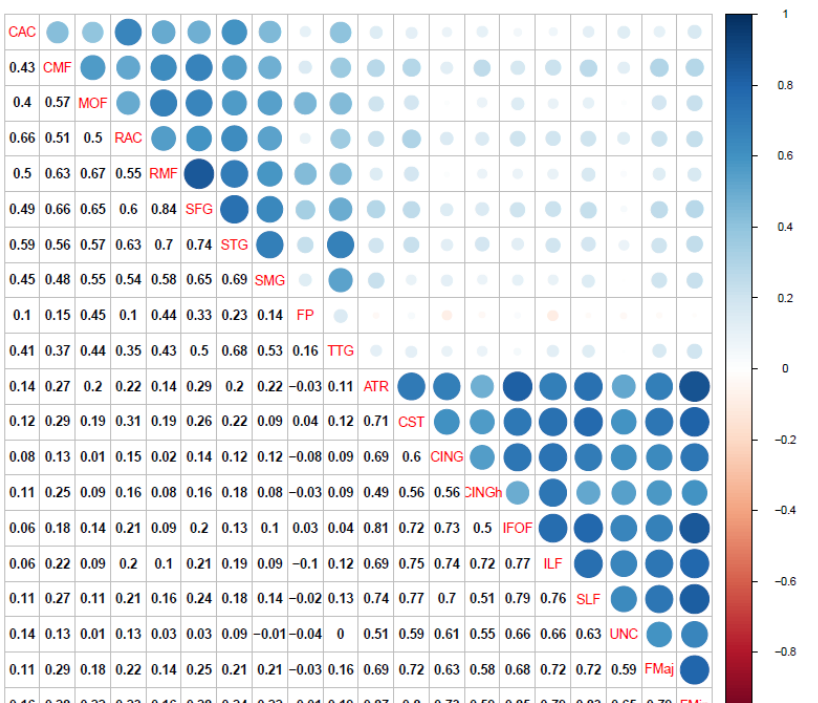
Figure 3. ( Top ) Correlation plot for cognitive raw scores and bilateral cortical volume ROIs. ( Middle ) Correlation plot for cognitive raw scores and bilateral fractional anisotropy ROIs. ( Bottom ) Correlation plot for bilateral cortical volume and bilateral fractional anisotropy ROIs. All coefficients shown are Pearson correlations. Blue represents positive correlations while red signifies negative correlations among variables. Size of circles indicates the magnitude of the association (e.g., larger circle = higher correlation). Correlations calculated using pairwise complete observations.